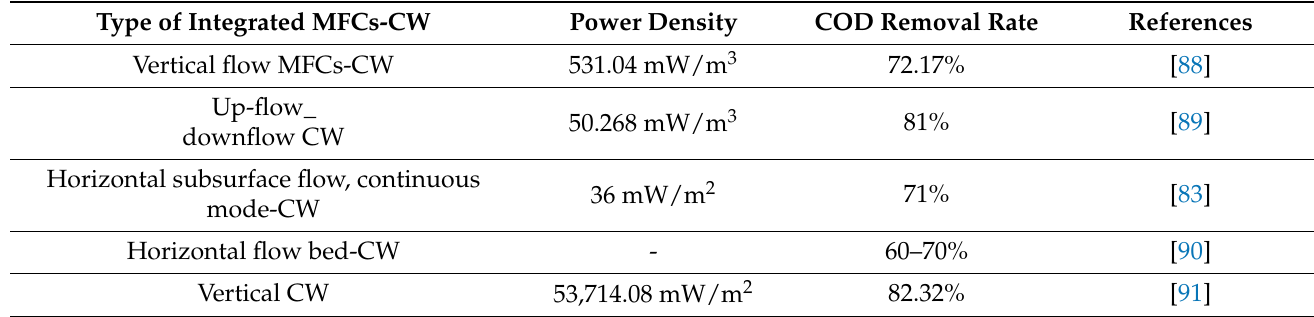
Table 3. Microbial-fuel-cell-integrated constructed